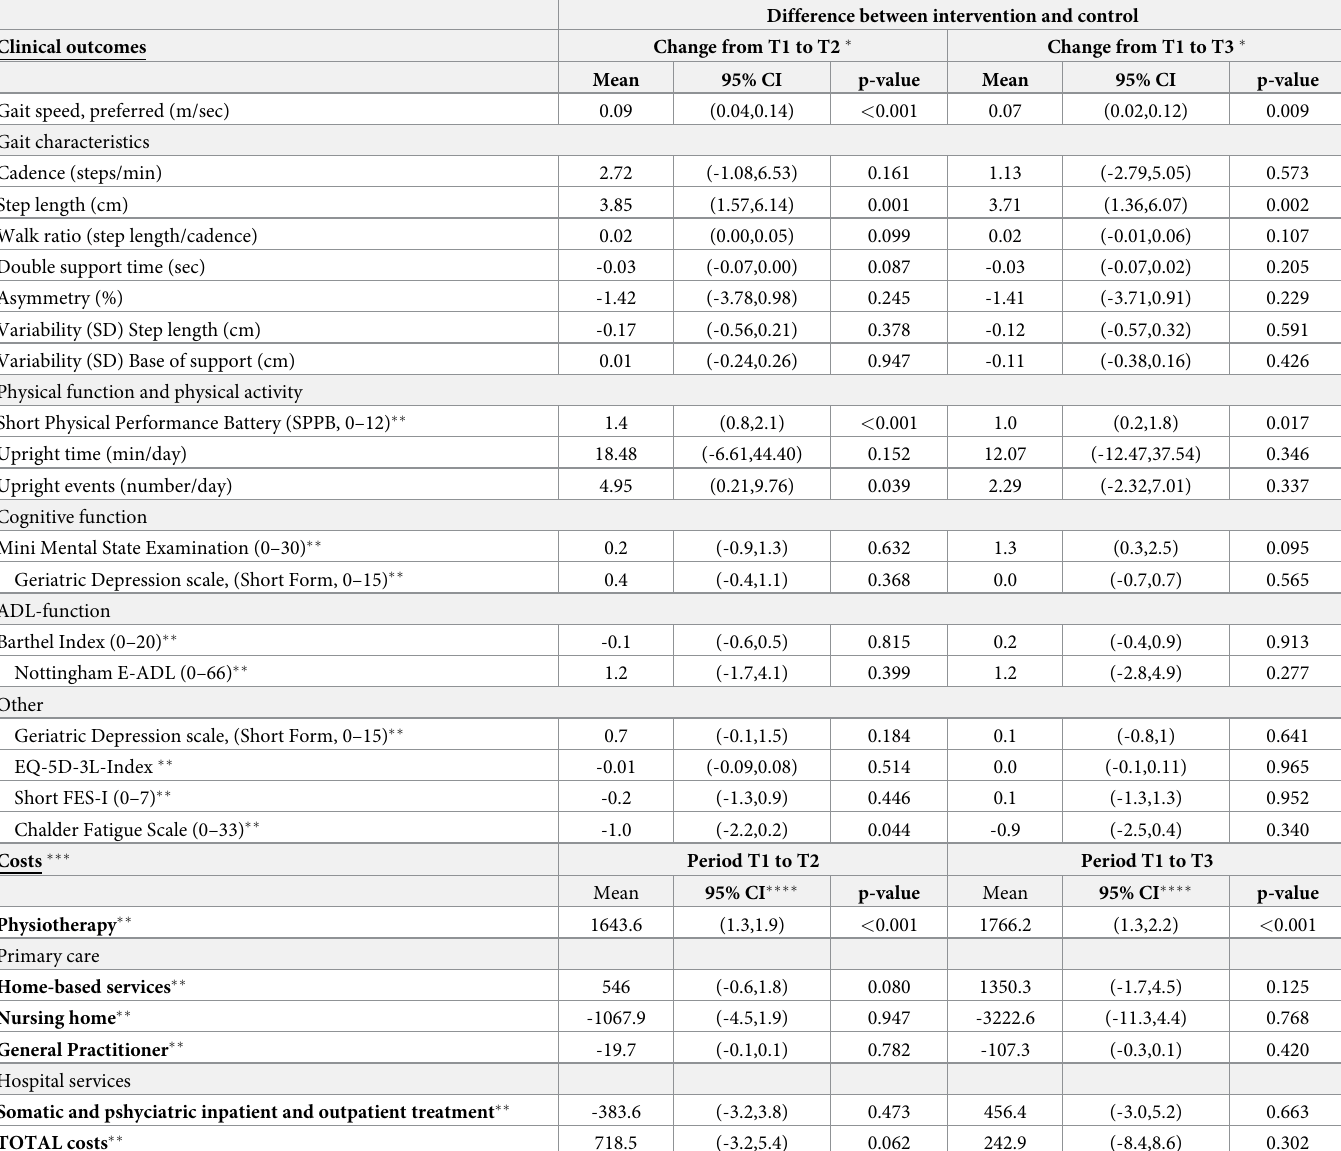
Table 2. Estimated between group differences in change for primary and secondary clinical outcomes and